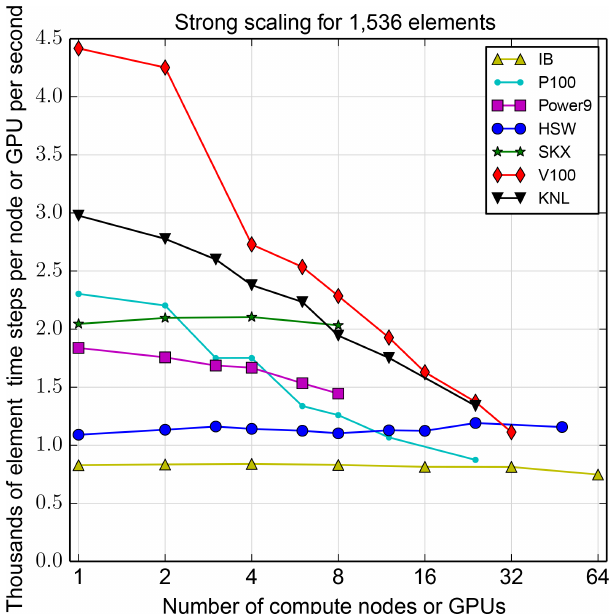
Figure 11. Strong scaling at small scale with Intel Xeon Haswell (HSW), Ivy Bridge (IB), and Skylake (SKX); Intel Xeon Phi Knights Landing (KNL); IBM Power9; and Nvidia GPU Pascal (P100) and Volta (V100) architectures for a 1536-element grid gen- erated with n e = 16 (1 . 875 ◦ resolution). See caption of Fig. 9 for details. Data are for HOMMEXX only.